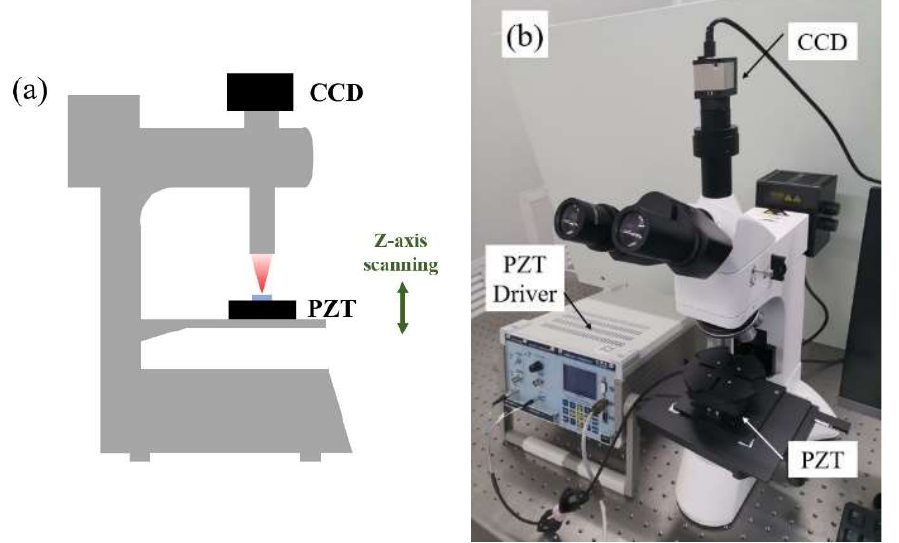
Figure 1. ( a ) Schematic and ( b ) photograph of TSOM setup. CCD, charge-coupled device; PZT, Piezoelectric Transducer.